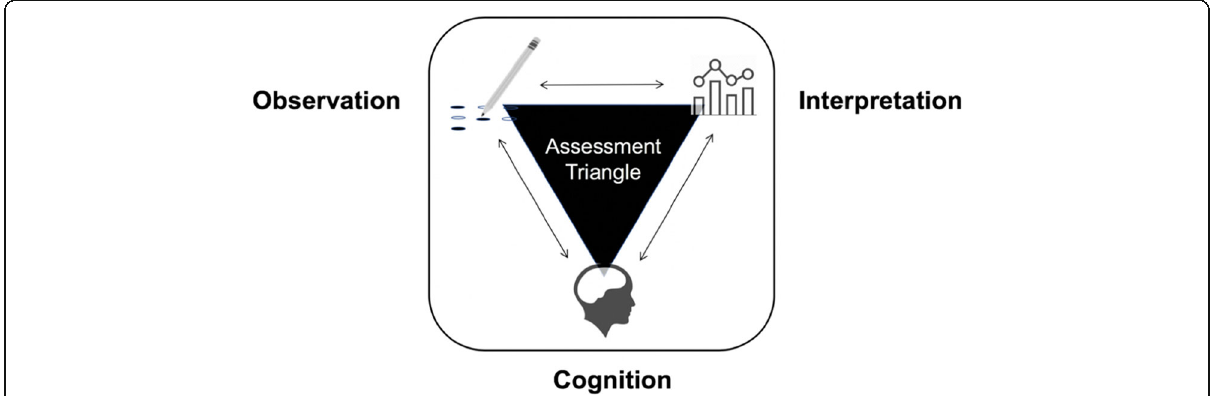
Fig. 2 The NRC Assessment Triangle. Measurement and assessment of student understanding requires the integration of cognitive models, observations, and interpretations of observations in light of cognitive models. Models of thinking about living systems — the cognition corner — are therefore crucial to the development, application, and evaluation of